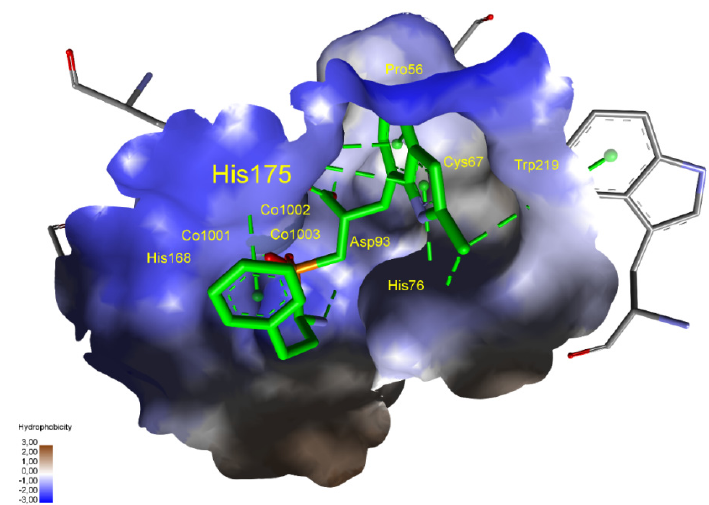
Figure 10. Modeled binding mode of a phosphinic dipeptide analog containing a 2-methylindol-7-yl P1 ′ fragment in the active center of Streptococcus pneumoniae glutamyl aminopeptidase (PDB: 3KL9). Amino acid residues of the inhibitor and enzyme are shown as sticks, while cobalt ions are shown as gray spheres. Hydrogen bonds and nonpolar interactions are shown as thin dashed lines. The surface is colored according to the hydrophobicity of amino acid side chains.